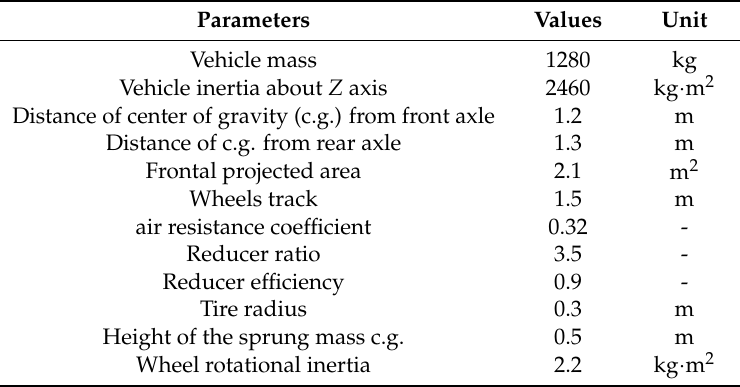
Figure 7. Heat loss and its reduction rate: ( a ) heat loss of different allocation approaches; and ( b ) heat loss reduction.